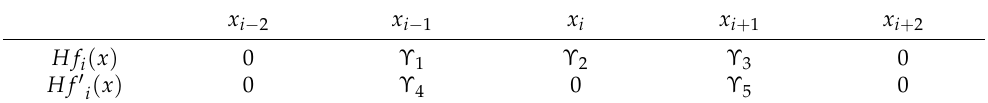
Table 1. The values of cubic hyperbolic B-spline functions at the